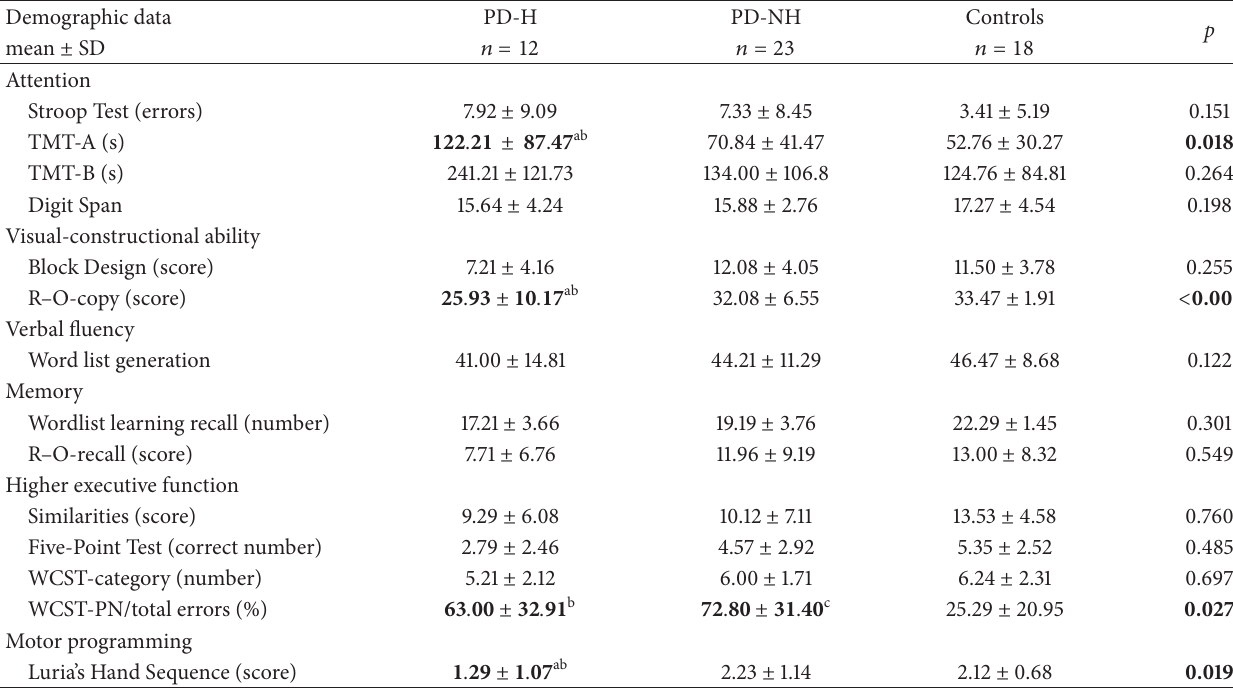
Table 2: Comparison of frontal test battery in PD patients and